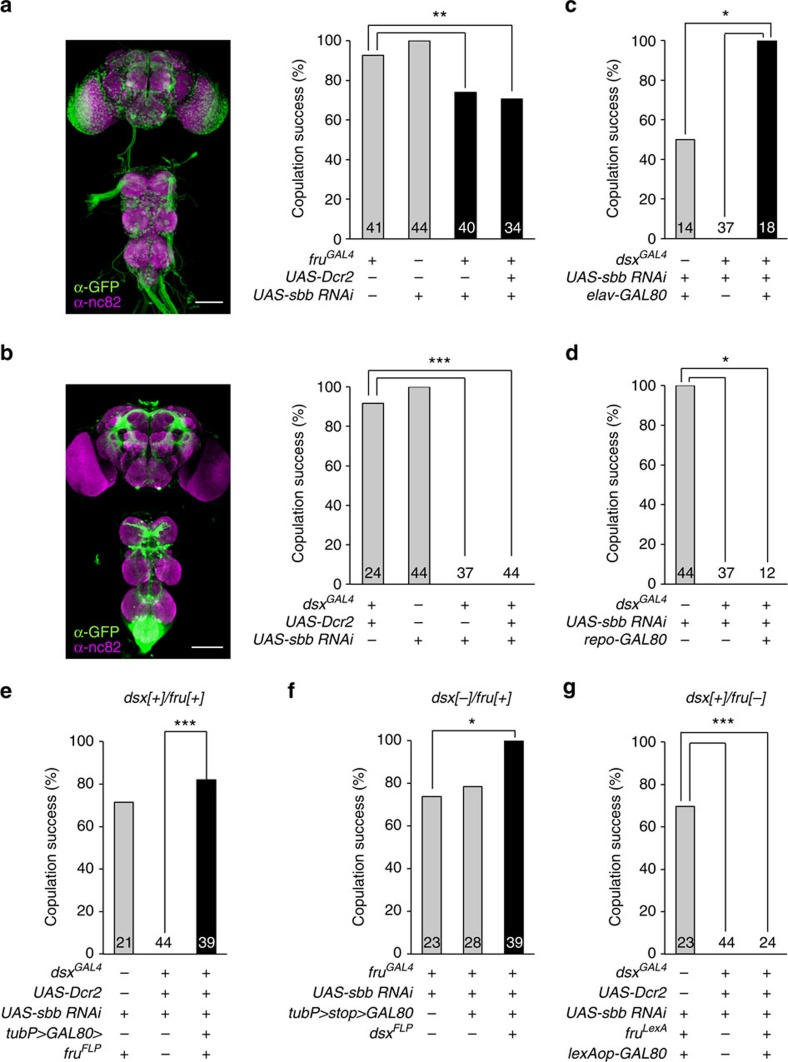
Contribution of neurons positive for fru and/or dsx and of glia to the copulation defect in flies with sbb knockdown.Images (left-side panels) of the CNS with fru-positive (a) or dsx-positive (b) neurons and the effect of sbb knockdown in the respective neurons (right-side panels) on the copulation rate. The genotypes of flies for the histological analysis are w; UAS-mCD8::GFP/+; fruGAL4/+ (a) and w; UAS-mCD8::GFP/+; dsxGAL4/+ (b), respectively. Scale bar, 100 μm. (c,d) Effect of neuron-excluded (c) or glia-excluded (d) sbb knockdown on copulation. (e–g) Effect of sbb knockdown in dsx[+]/fru[+] (e), dsx[−]/fru[+] (f) or
dsx[+]/fru[−] (g) on copulation. *P<0.05; **P<0.01; ***P<0.001 by the χ2-test. Data are presented as described in the legend of Fig. 1.